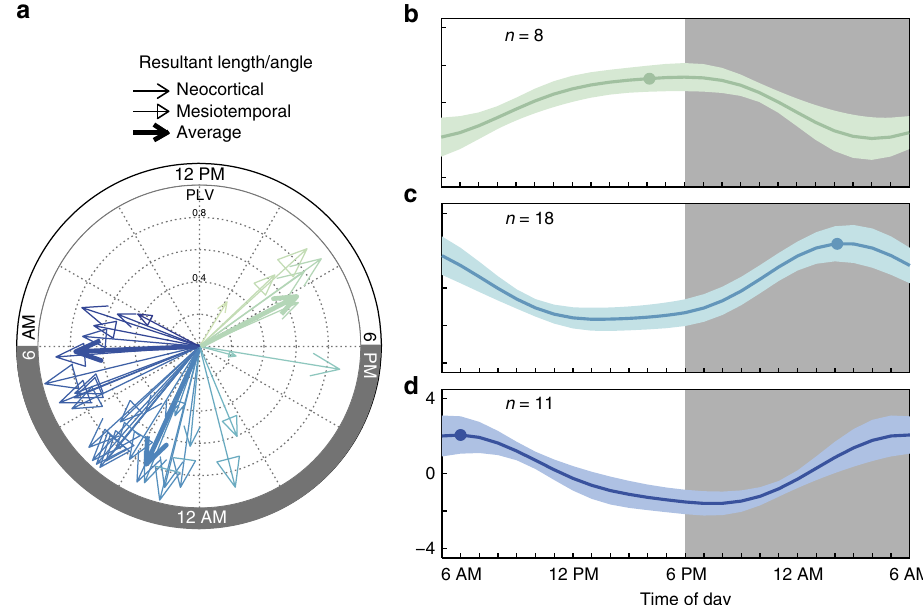
Fig. 3 Circadian timing of peak IEA. a Phase entrainment of peak circadian rhythm to time of day for each subject ( N = 37, 85 – 3478 days, resultant angle and phase-locking value (PLV), p < 0.0001 for all, Omnibus test, see Methods section) grouped into three clusters (group mean angle and PLV in bold, corresponding time as a dot in ( b – d ). Normalized average circadian amplitude ( ± SD) with peak in the late afternoon ( b ), early night ( c ), and early morning ( d ) were independent of seizure localization (mesial temporal vs. neocortical, p = 0.14, χ 2 -test) but may represent three